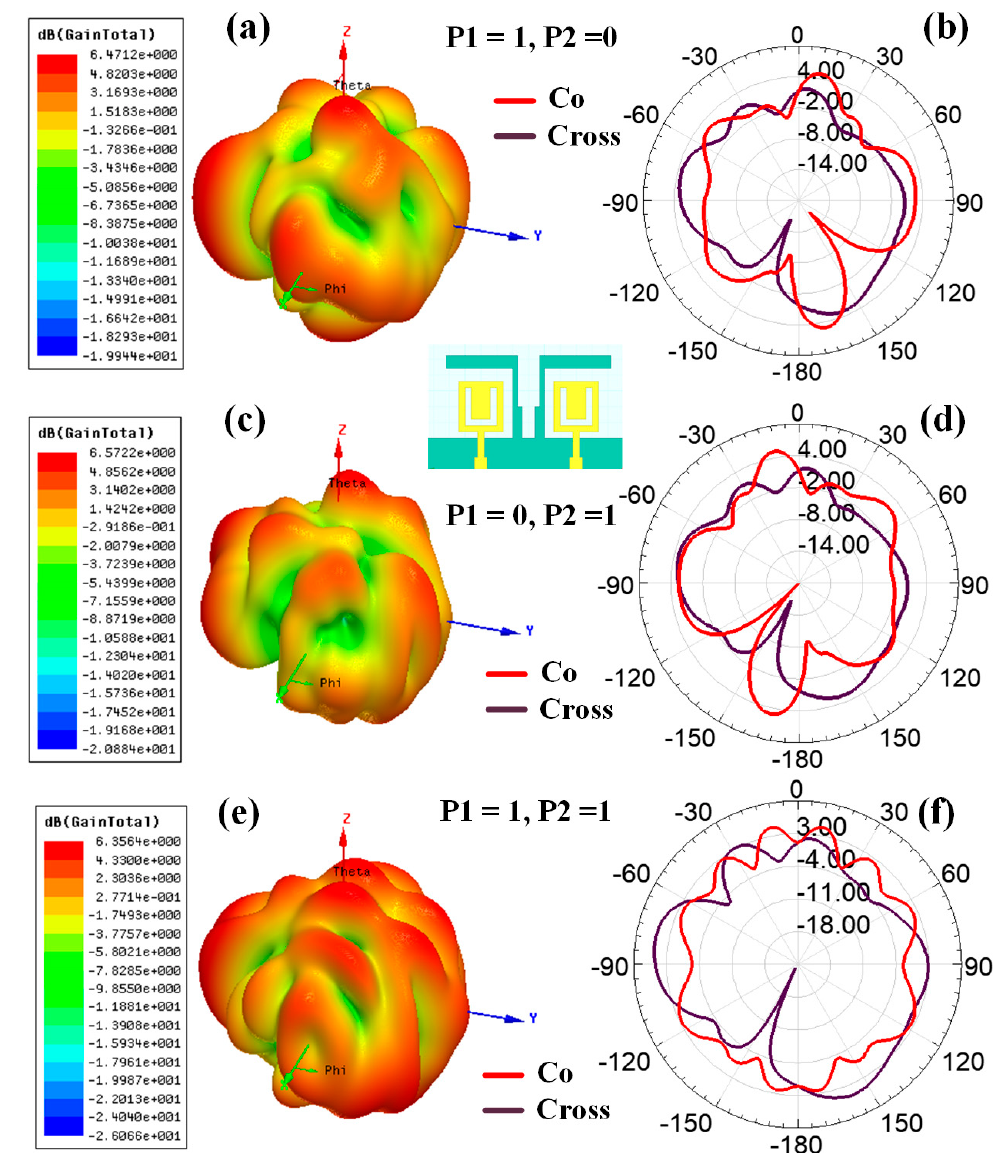
Figure 11. Variation in the polar plot for the different port excitation conditions (Design 4) (simulated results). The 3D polar plot for the ( a ) (P1, P2) = (1, 0), ( c ) (P1, P2) = (0, 1), and ( e ) (P1, P2) = (1, 1). 2D polar plot for the ( b ) (P1, P2) = (1, 0), ( d ) (P1, P2) = (0, 1), and ( f ) (P1, P2) = (1, 1), with co-polar and cross-polar